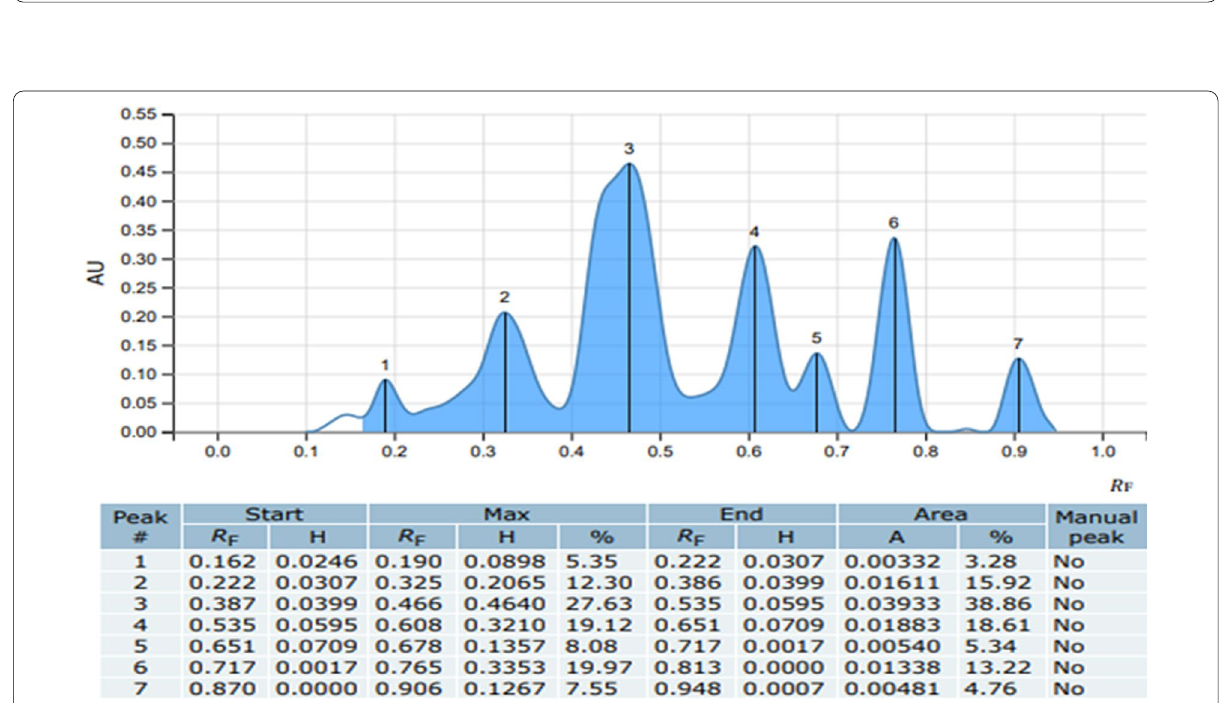
Fig. 3 Peak chromatogram band of E. indicum aqueous extract using the solvent system A (ethyl acetate/methyl ethyl ketone/formic acid/water in the ratio of 5:3:1:1)